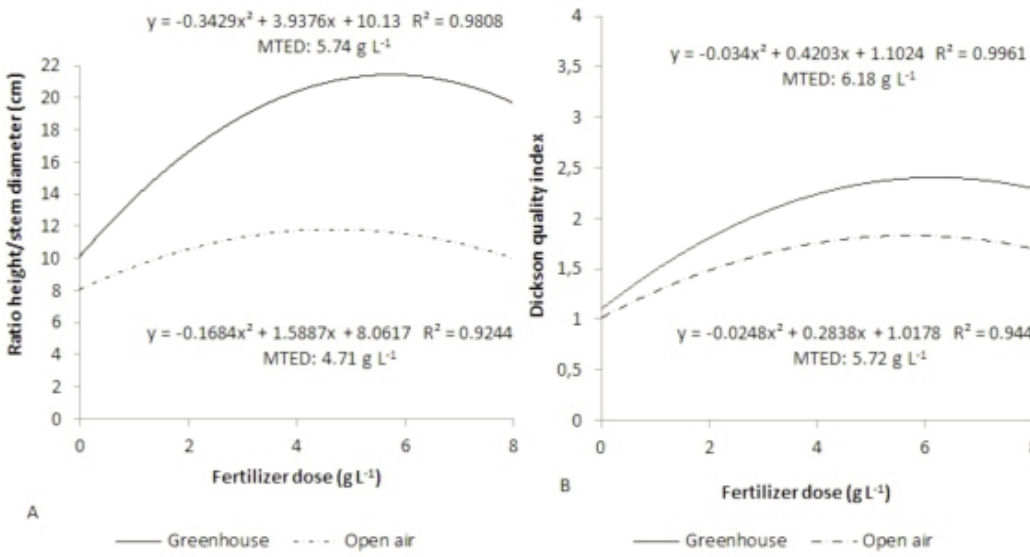
Fig. 4 ­ Ratio between height and stem diameter and Dickson quality index of peach plants cv. Capdeboscq, in relation to the dosage of controlled­release fertilizer and two